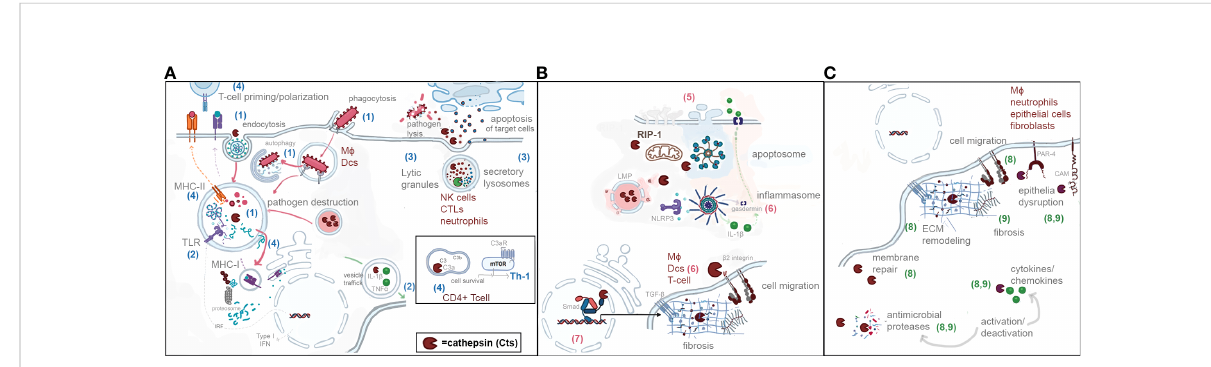
FIGURE 1 Schematic representation of the spatial localization of cathepsins and their roles in endocytic pathway (A) (blue numbers from 1 to 4), (B) cytosol and nucleus (pink numbers from 5 to 7), and (C) extracellular environment (green numbers 8 and 9). (1) Phagocytosis/endocytosis/ autophagy. (2) Pattern recognition/cytokine activation. (3) Activation of proteases. (4) T-cell priming and polarization. (5) Programmed cell dead. (6) In fl ammation. (7) Regulation of transcription. (8) ECM remodeling. (9) ECM in fl ammation during